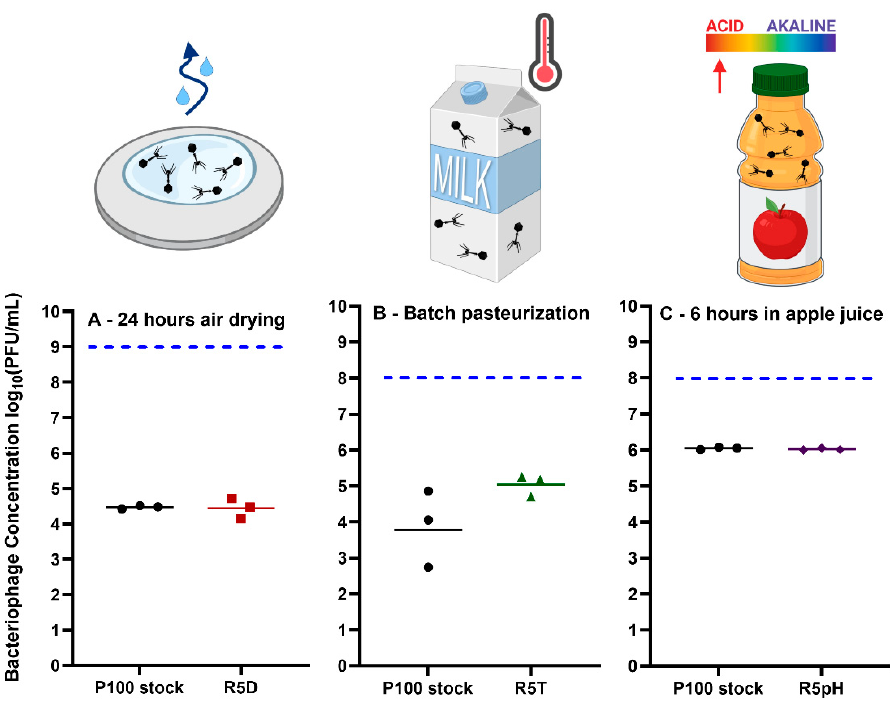
Figure 7. Remaining bacteriophage concentration (PFU/mL), of P100 stock and the reversion-tested bacteriophage samples R5D, R5T or R5pH after exposure to ( A ) 24 h of air drying on a food-grade stainless-steel sheet, ( B ) 63 ◦ C for 30 min within milk (batch pasteurization), and ( C ) apple juice for 6 h. Triplicate results are shown, where the geometric mean is marked as a horizontal line. Black circles represent the P100 ancestral stock, red squares represent the R5D sample, green triangles represent the R5T sample, and purple diamonds represent the R5pH sample. The horizontal dotted blue line represents the initial concentration of the P100 and reversion-tested samples. This starting concentration was selected based on available application sheets for P100, that is, a concentration of 1 × 10 9 PFU/mL on food preparation surfaces and 1 × 10 8 PFU/mL within liquid food